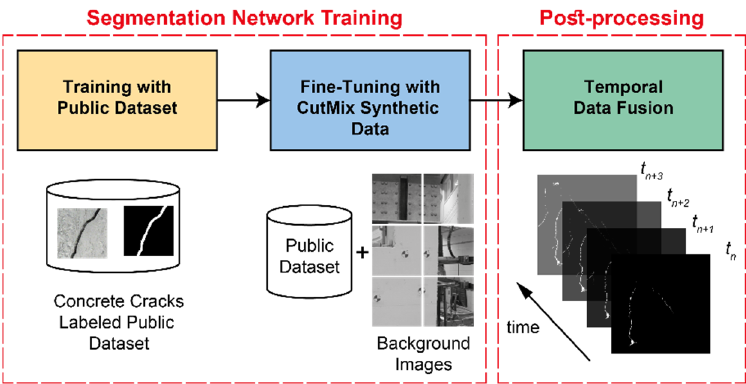
Figure 2. Overview of the proposed framework.